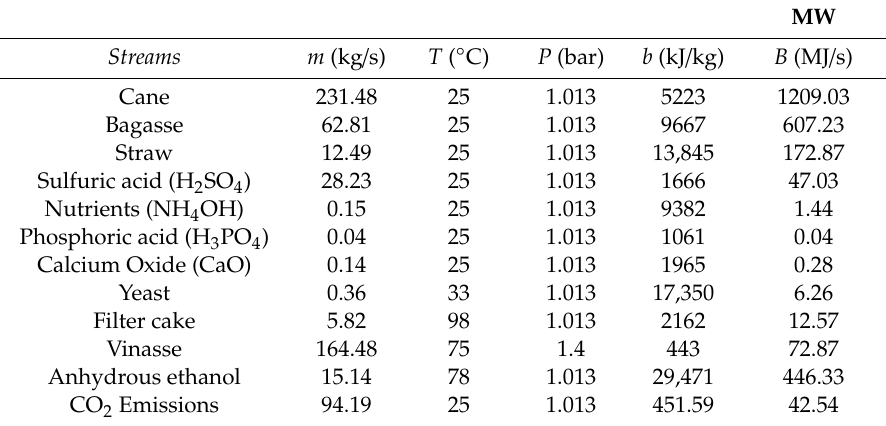
Table A15. Key streams parameters of the traditional ethanol production (1G).